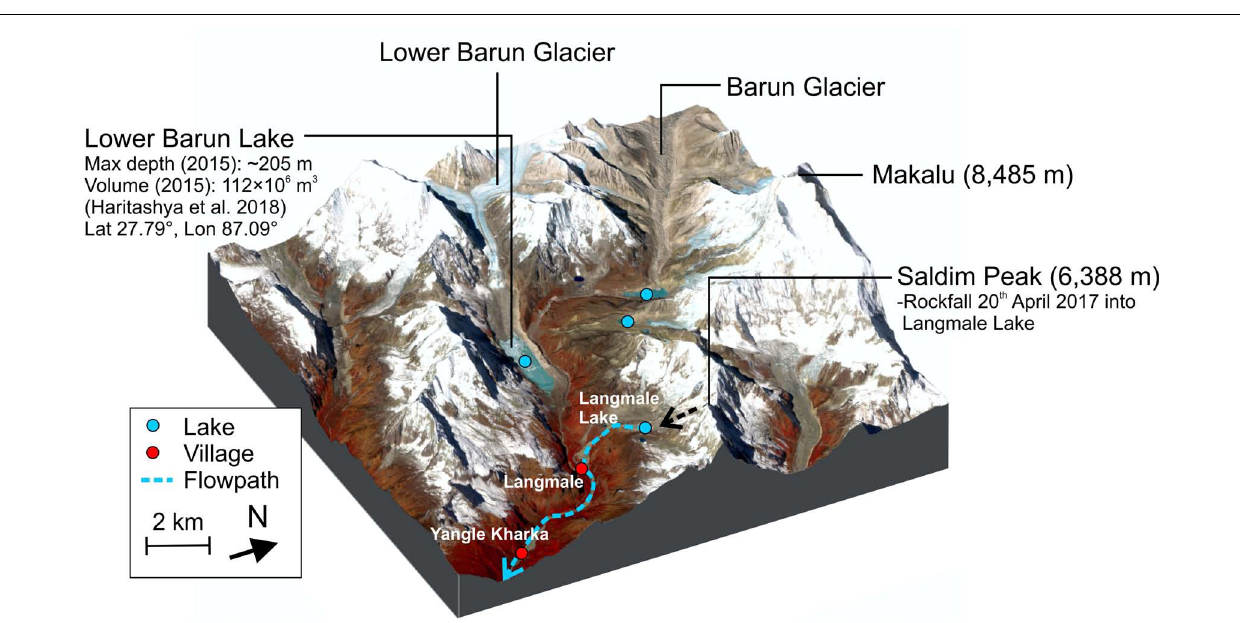
Frontiers in Earth Science |